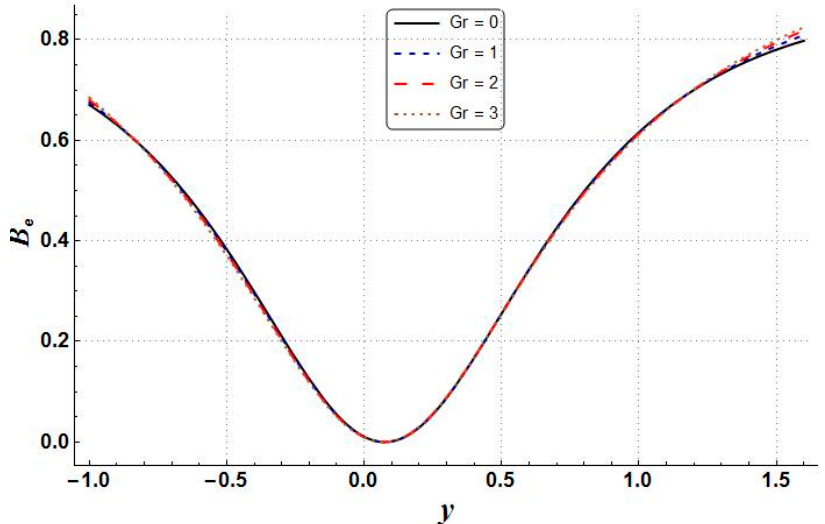
Figure 35. Influence on B e through changing values of Gr , where γ = π B α = π , φ = 0.05, k = 2, a = 0.6, M = 1, d = 0.7, m = 1, b = 0.5, ∈ = 2, η = 0.8. 4